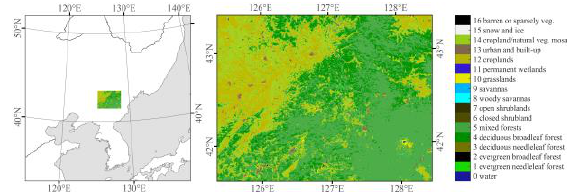
Figure 1. The study area and its land use and cover types